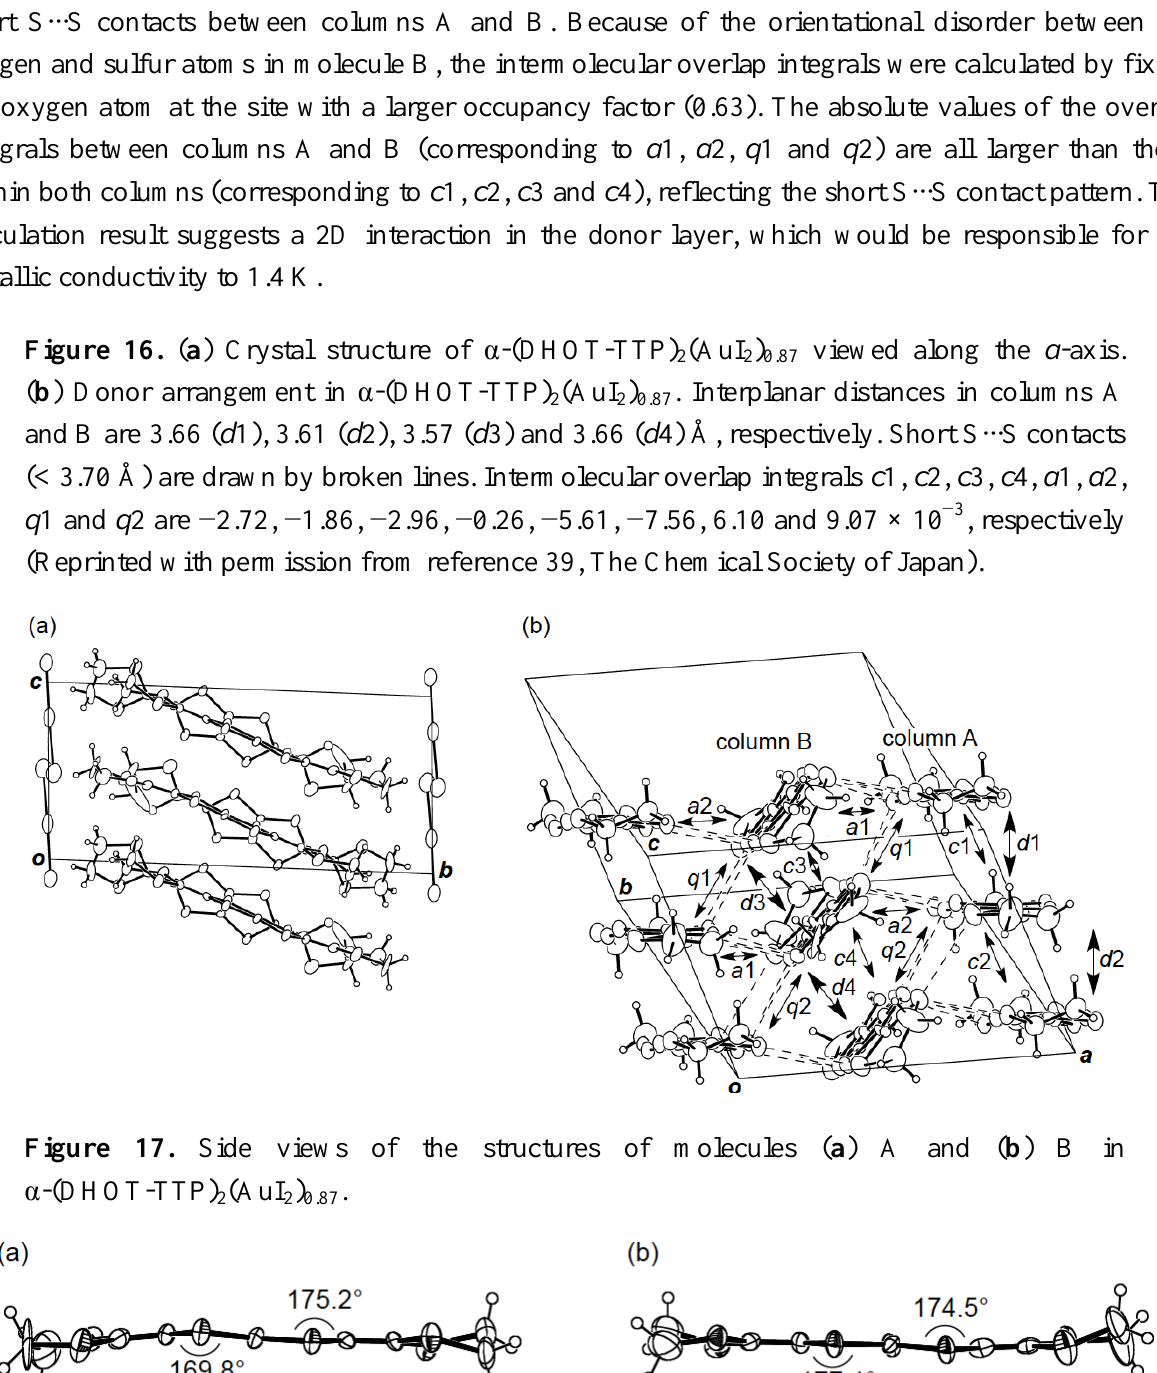
(AuI ) viewed along the a -axis. 2 2 0.87 (AuI ) . Interplanar distances in columns A 2 2 0.87